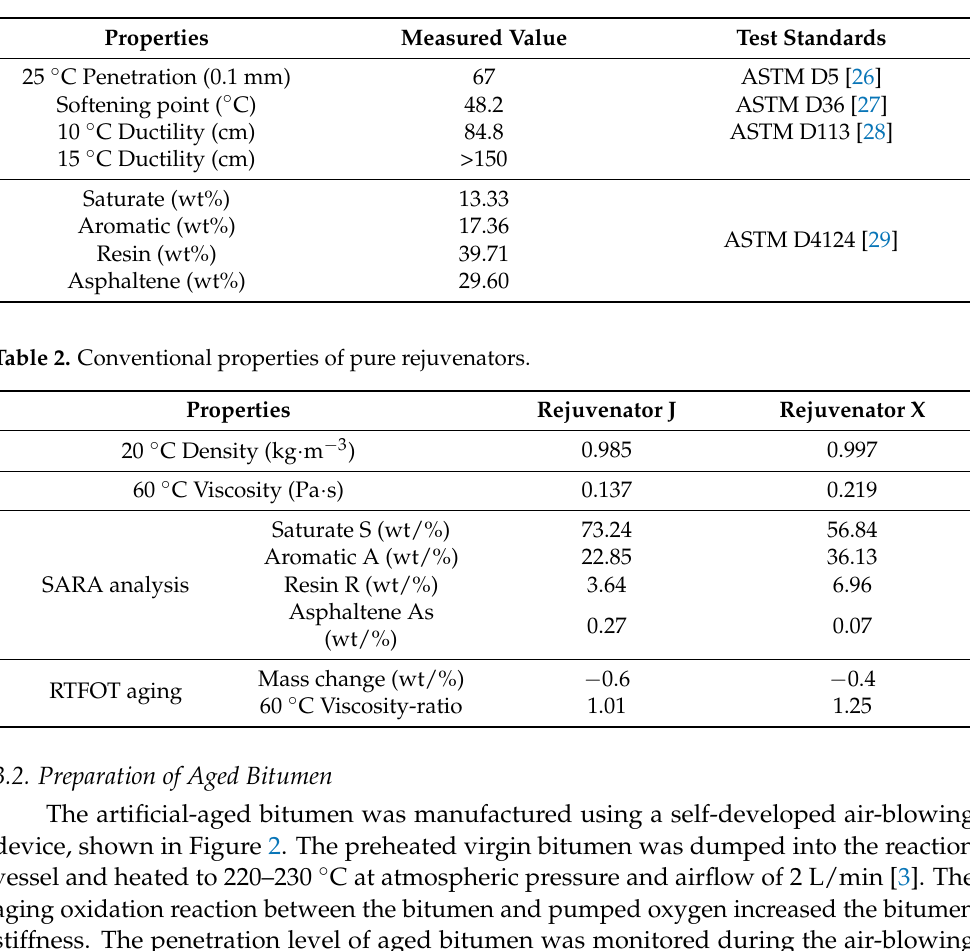
Table 1. Physical properties and chemical components of virgin bitumen.